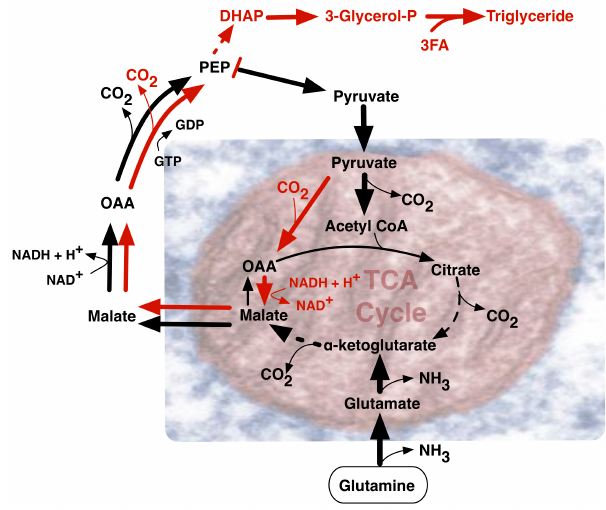
Figure 3. Glutamine metabolism: The influence of anaplerosis (entry of glutamine into the TCA cycle), cataplerosis (removal of glutamine as malate) and glyceroneogenesis (marked red). Mechanisms by which glutamine is metabolized for energy involve entry of glutamine into the TCA cycle (anaplerosis), balanced by its removal (cataplerosis) as malate. Malate can be subsequently converted to oxaloacetate